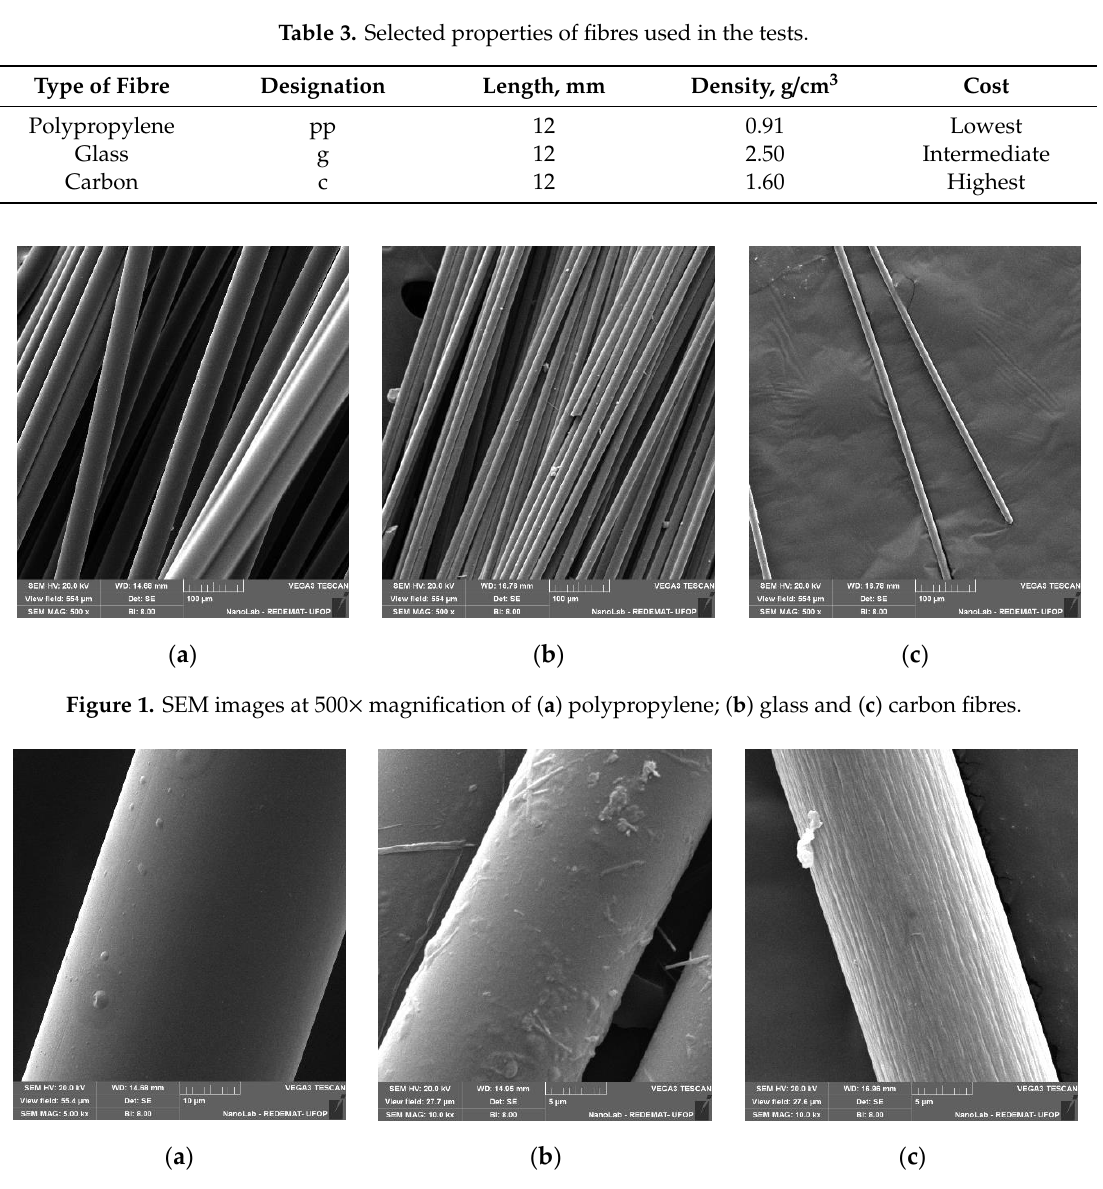
Figure 2. SEM images of ( a ) polypropylene at 5000× magnification; ( b ) glass and ( c ) carbon fibres at 10,000× magnification.